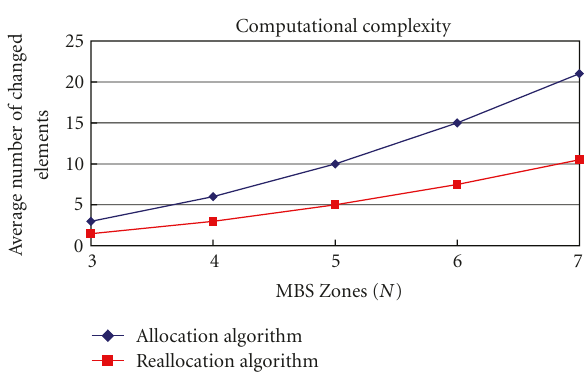
Figure 11: Computational complexity of the proposed algorithms.